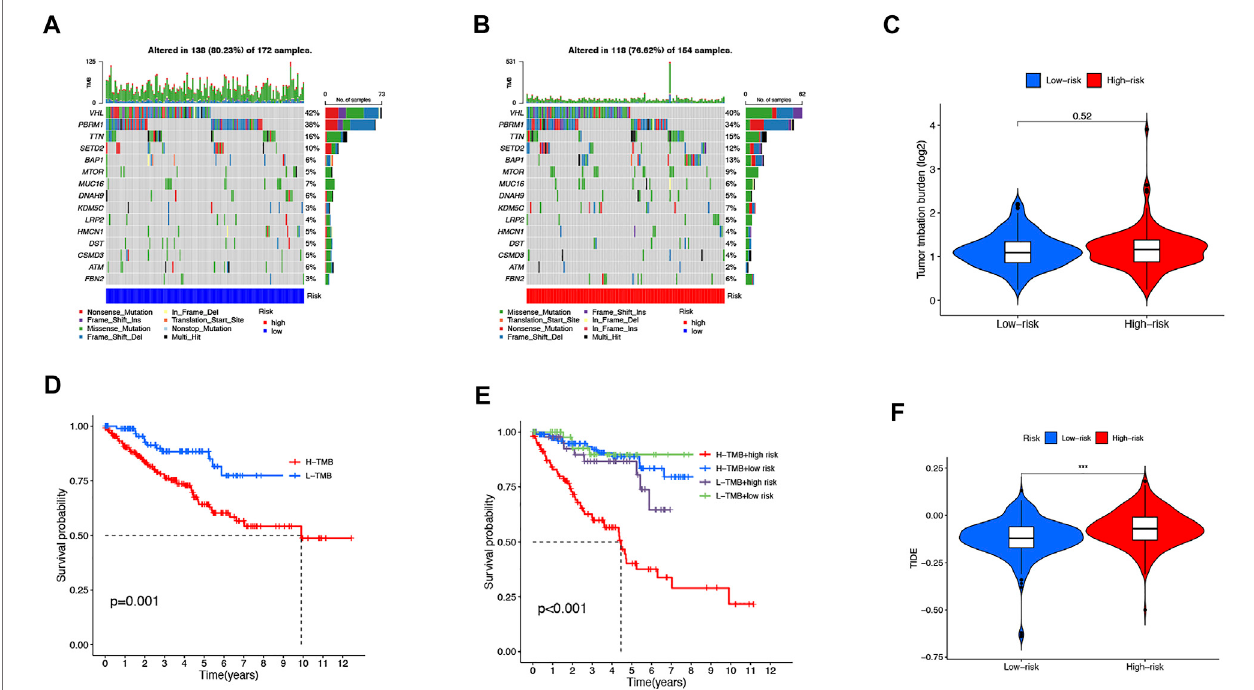
FIGURE 9 | TMB, TIDE, and Chemotherapeutic Sensitivity. Waterfall plots of somatic mutation characteristics in the two groups (A-B) . TMB between the low-risk and high-risk groups (C) . K – M survival curves between the high- and low-TMB groups (D) . K – M survival curves between the four groups (E) . TIDE scores between the two groups (F) .